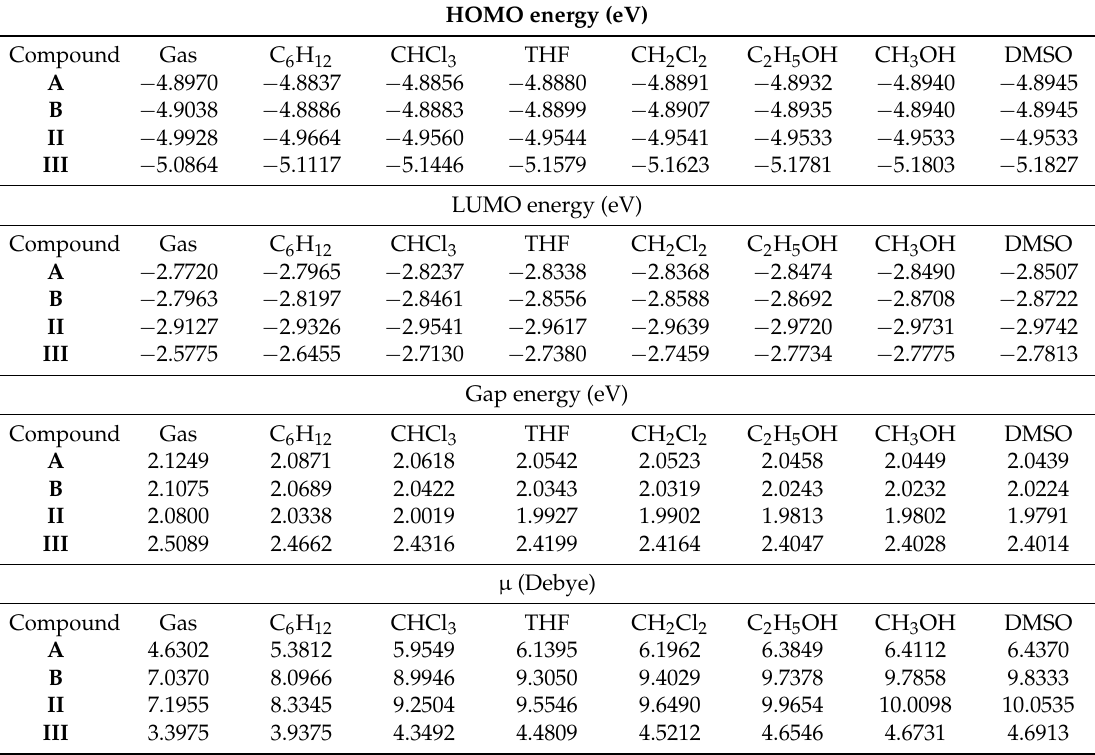
Table 5. Theoretical data of I , II and III in gas and solvent phases at M06L/cc-pVDZ theory